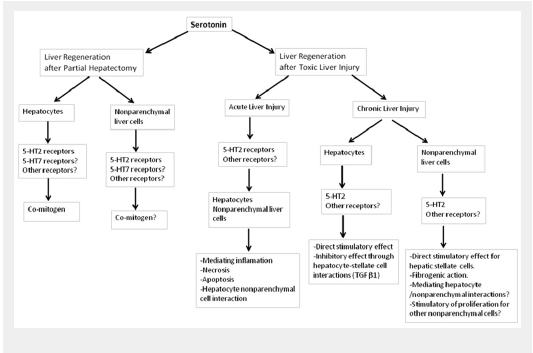
Schematic summary of the most important roles of serotonin in liver